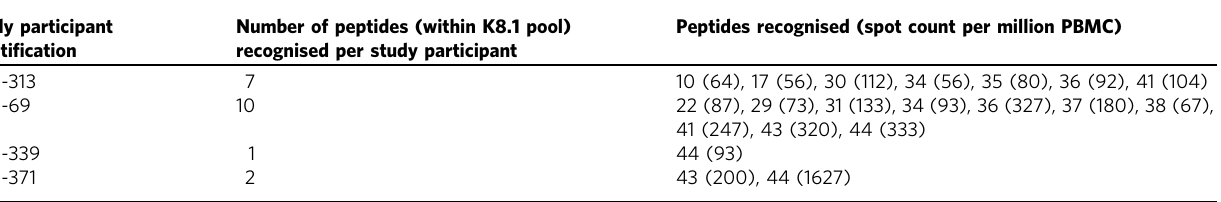
Table 2 Identi fi cation of responding peptides within the K8.1 peptide pool (44 peptides). Study participant identi fi